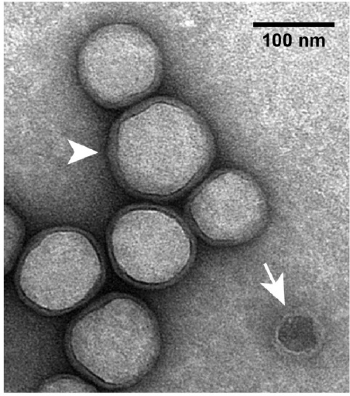
Figure 4. Electron microscopy of hyper-expanded NLD capsid II. The sample was the same as the sample used for Figure 2a. Particles in the sample were negatively stained with 1% uranyl acetate. The procedures of specimen preparation and EM were the same as used in reference